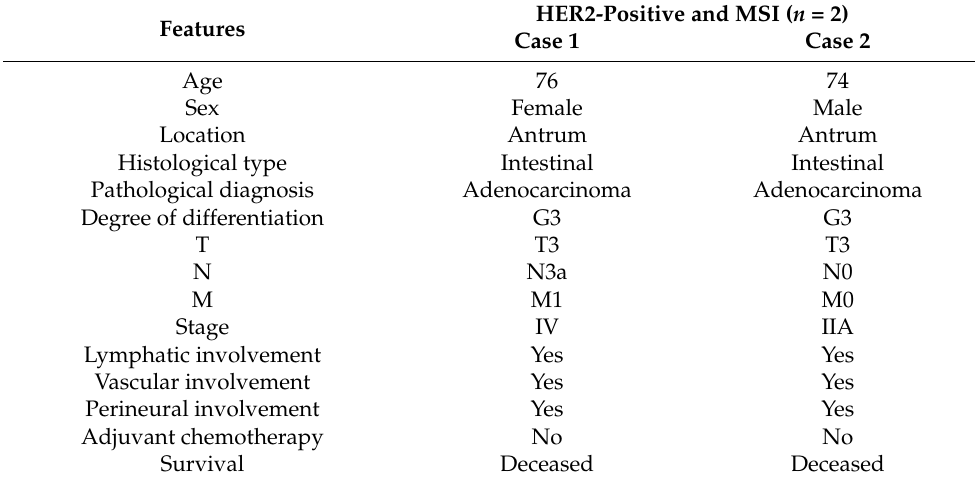
Table 5. Clinical and pathological features of the gastric cancer patients showing both HER2-positive and MSI